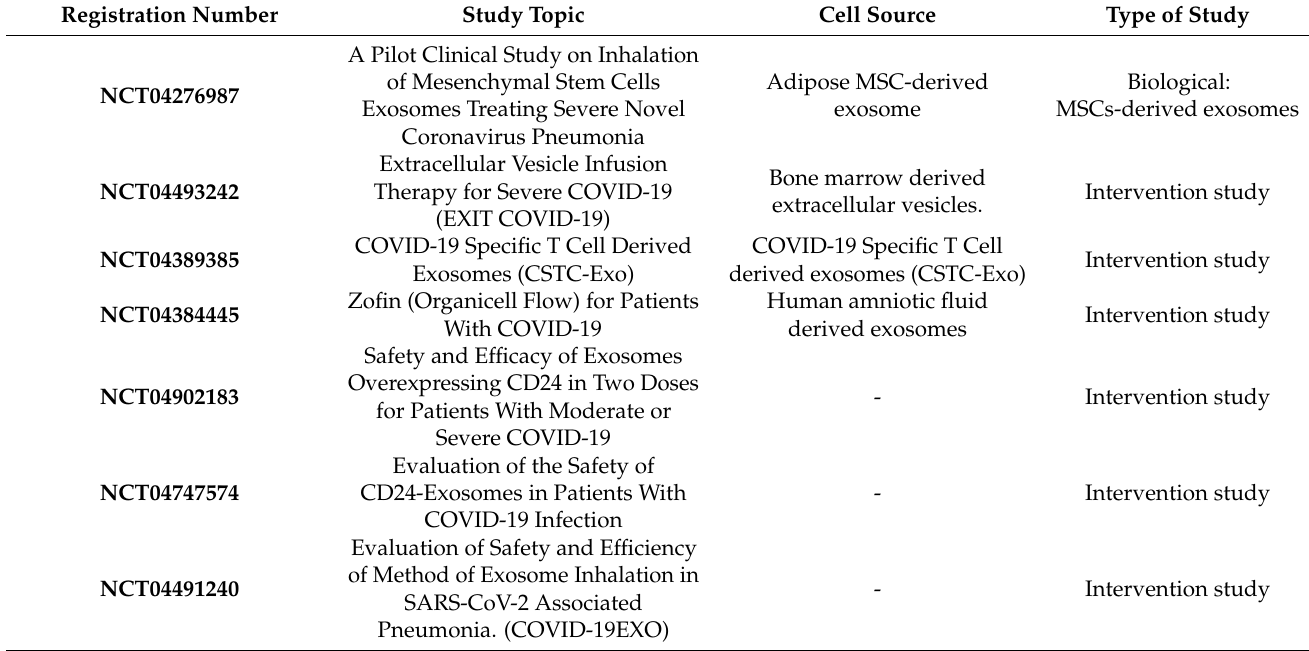
Table 9. List of registered exosome cell based clinical trials for the treatment of COVID-19. Registration Number Study Topic Cell Source Type of